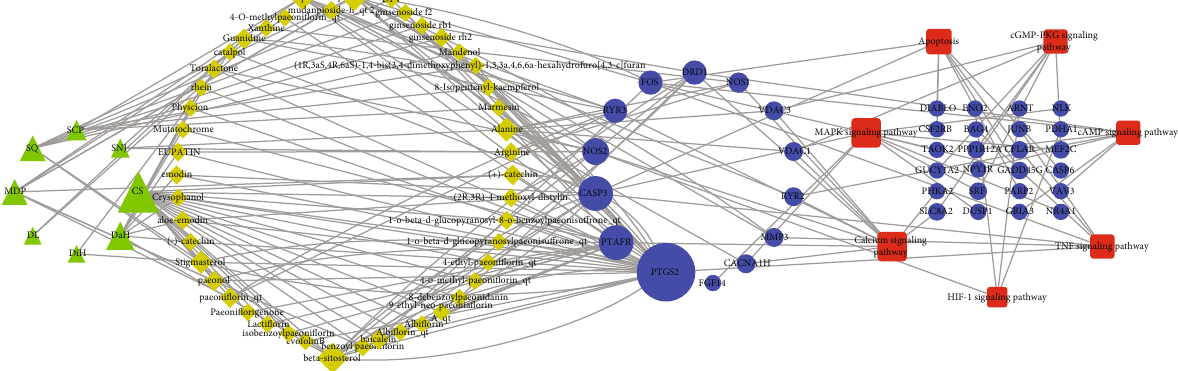
Figure 8: Herb-Compound-Target-Pathway(H-C-T-P) veri fi ed network related to the treatment of LXTYF for AICH in RNA-seq. Green triangles represent 8 herbs, yellow diamonds represent 46 compounds, blue ellipses represent 38 targets, and red round rectangles represent 7 pathways. A larger degree of the target nodes with larger